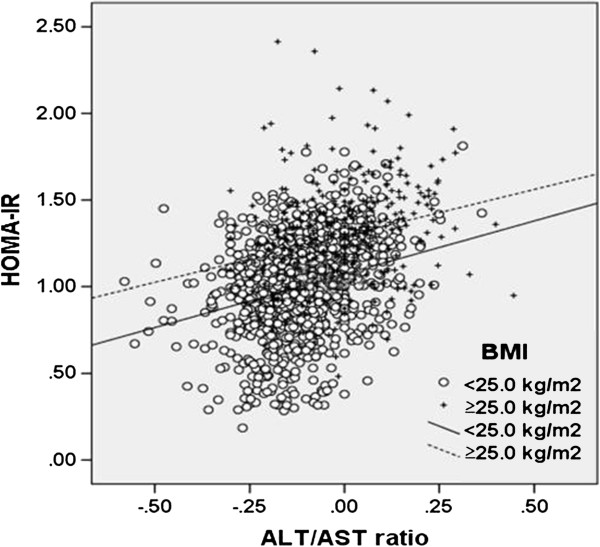
Correlation between AST/ALT ratio and HOMA-IR categorized by BMI. Data for HOMA-IR were skewed and log-transformed for analysis. The lines of best fit (BMI <25.0 kg/m2: r = 0.274, P < 0.001; BMI ≥25.0 kg/m2: r = 0.253, P < 0.001) are indicated.